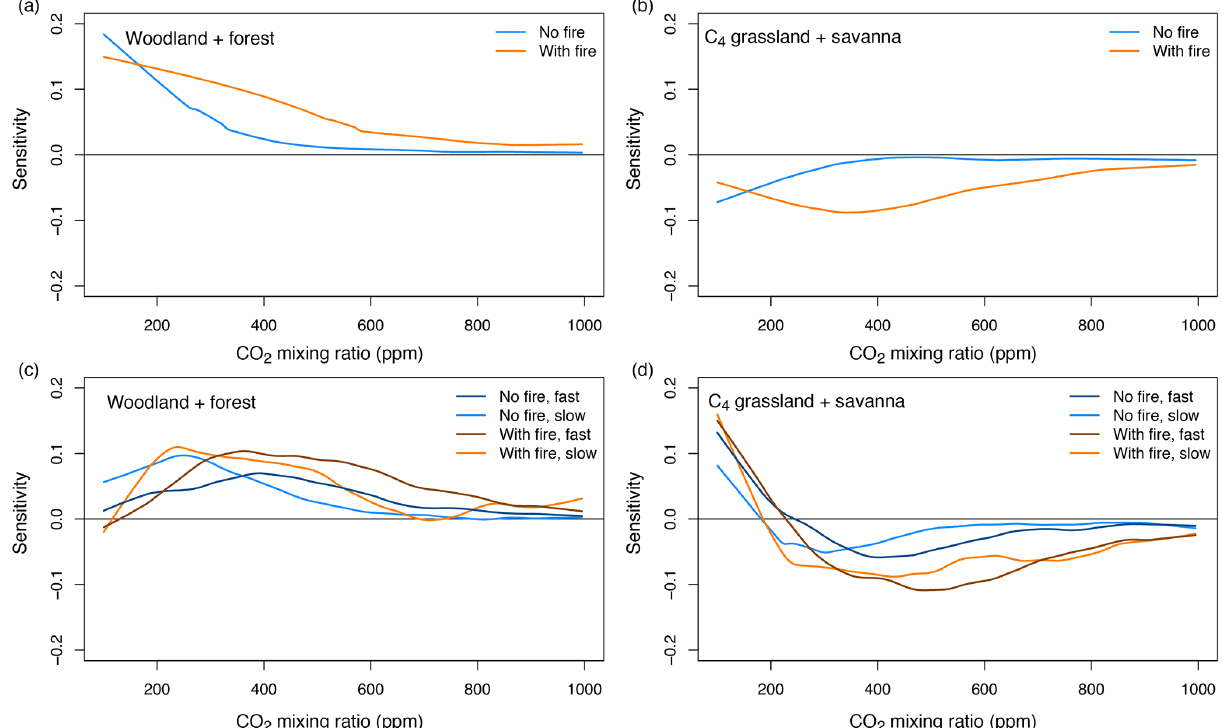
Figure 8. Sensitivity of vegetation cover change to changes in the atmospheric CO 2 mixing ratio (in percent change of vegetation cover per part per million increase). Upper panels (a, b) show equilibrium simulations; lower panels (c, d) show transient